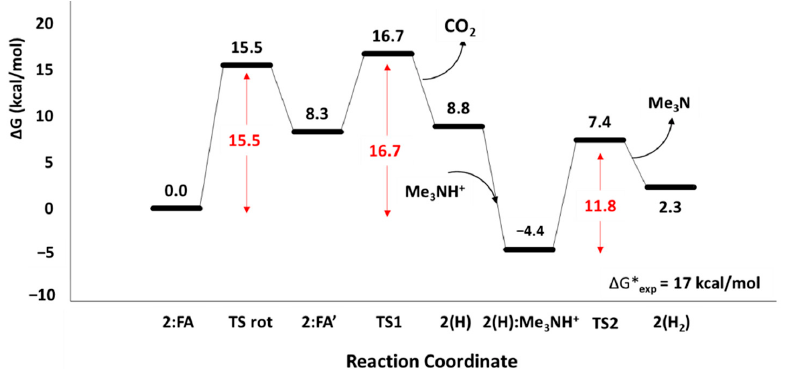
Figure 1. Free energy profile of the FA to CO 2 conversion catalyzed by complex 2 at the B3LYP-D3/6-311+G(2d,2p)/SDD/Chlorobenzene level of theory. Energy barriers are depicted in red.